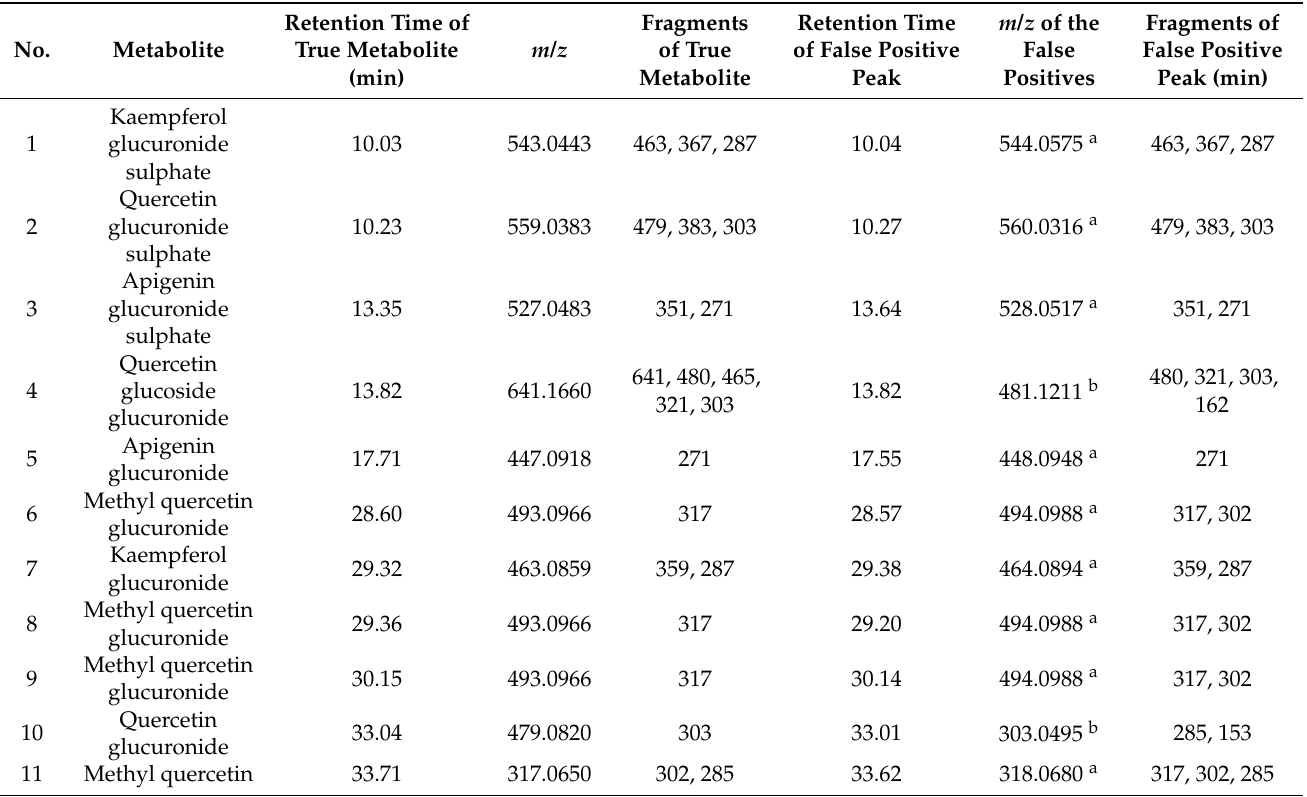
Table 3. The false positive metabolites of Tartary buckwheat extracts in rat biological